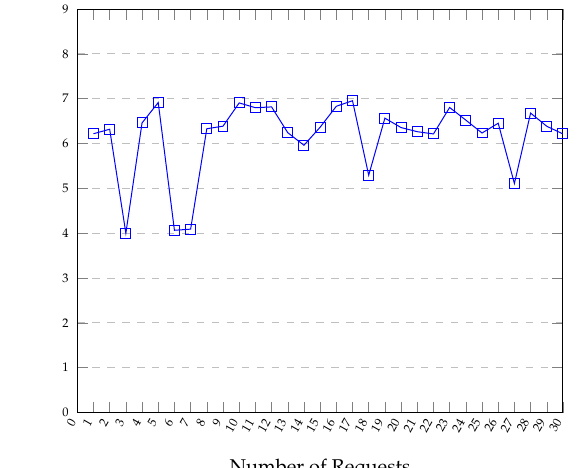
Figure 9. The time required to send and receive a response to an access request is illustrated as a function of the number of requests. The access-request transaction incurs an average latency of 6.275